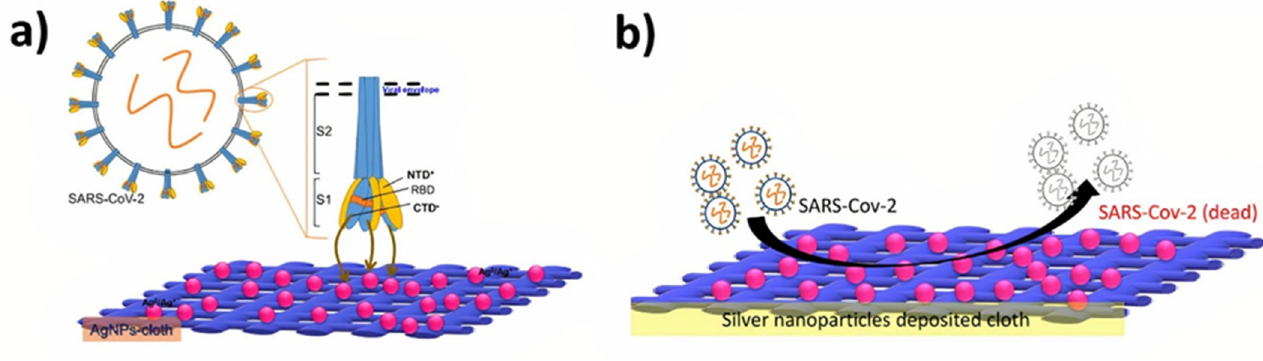
Figure 10. Inactivation of SARS-CoV-2 virus in clothes using AgNPs. ( a ) Structure of virus con- taining lipid membrane and glycoprotein spikes, ( b ) Inactivating the COVID virus. Reprinted with permission from Elsevier [137]. 2022, Karthik V Shankar.